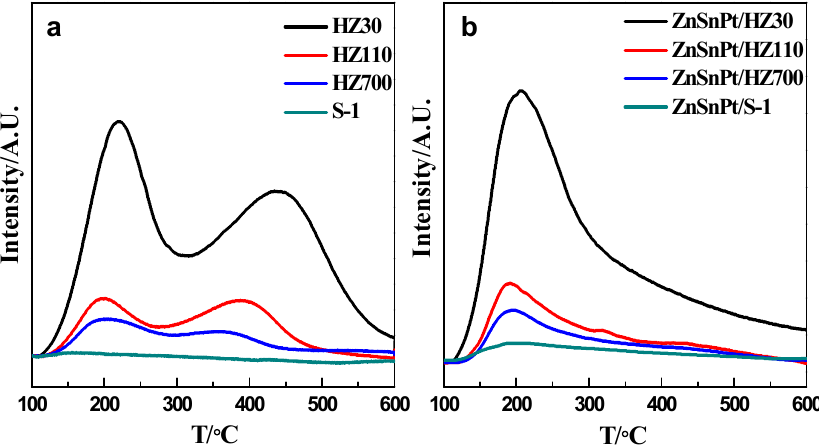
Figure 6. ( a ) The NH 3 -TPD profiles of defective MFI zeolites with different SiO 2 /Al 2 O 3 ratios; ( b ) Zn–Sn–Pt modified defective MFI zeolites with different SiO 2 /Al 2 O 3